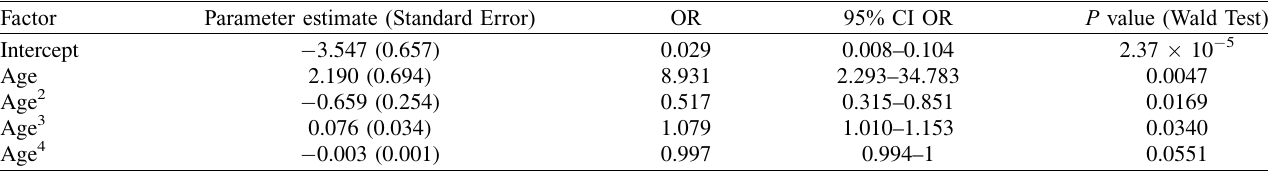
Table 8. Final model to explain Toxoplasma gondii seropositivity at a cut-off titer of 6 (1642 observations). Factor